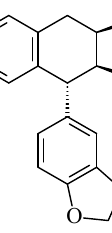
Figure 6. Picropolygamain isolated from B. simaruba [40].